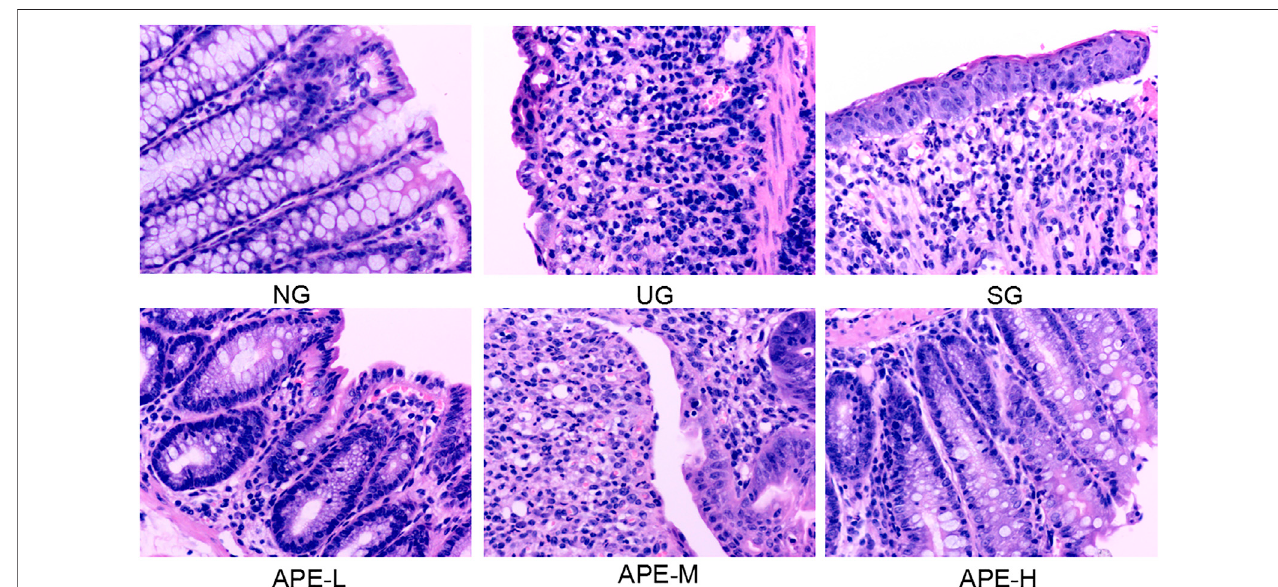
FIGURE 5 | Effects of APE on the pathological alterations in the colon. Representative images of hematoxylin and eosin stained sections (H and E staining, 200 × ). APE, Alhagi pseudalhagi extract.